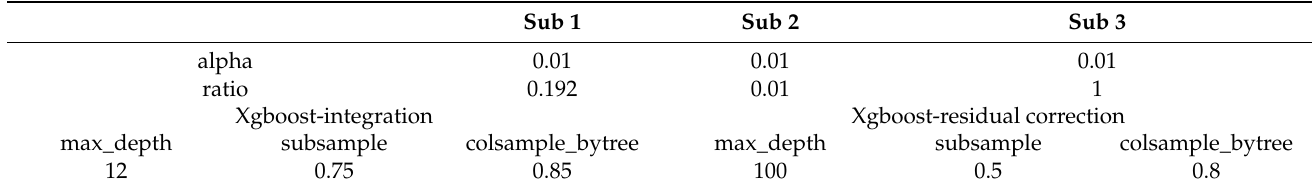
Table 5. Parameters used in case 3.